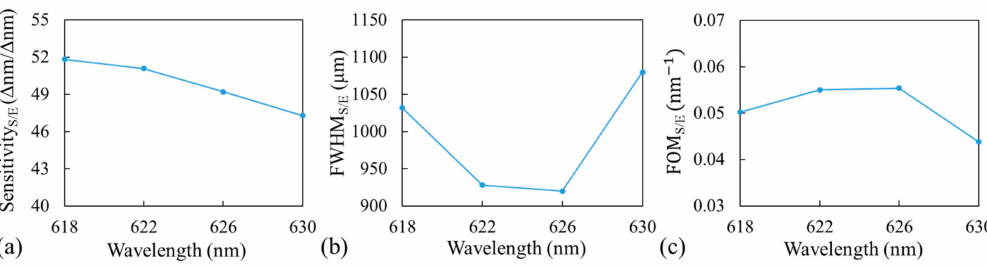
Figure 5. ( a ) Sensitivity S/E , ( b ) FWHM S/E , and ( c ) FOM S/E from surface-adsorbed layer measurement at four incident wavelengths. Here, the subscript S/E indicates experimental results (E) obtained with the surface-adsorbed layer